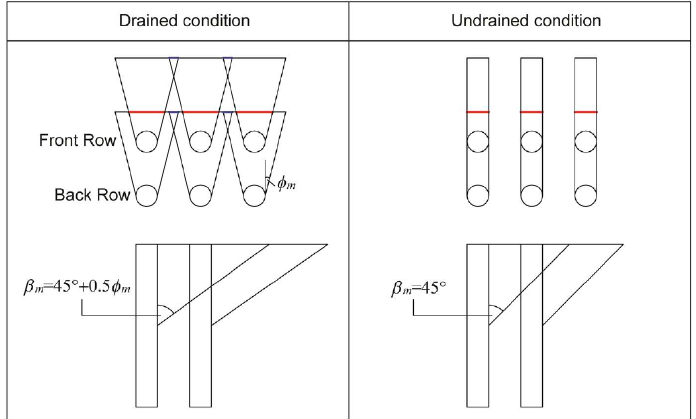
Figure 6. Pile group effect: shadowing modeling.